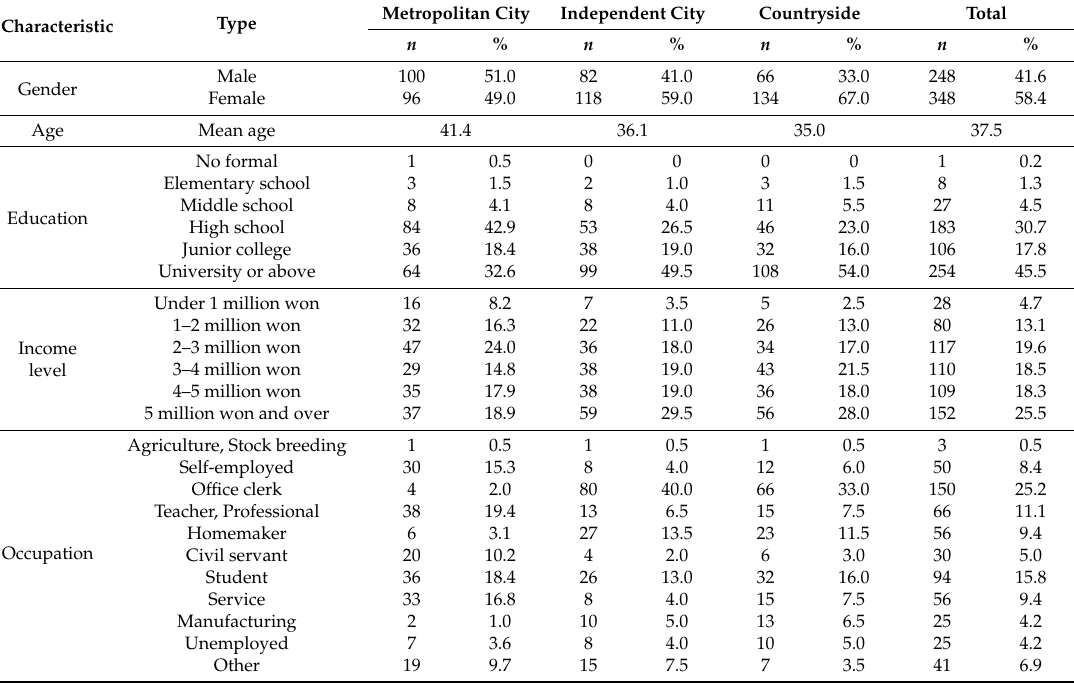
Table 2. Participants’ demographic characteristics ( n = 596).